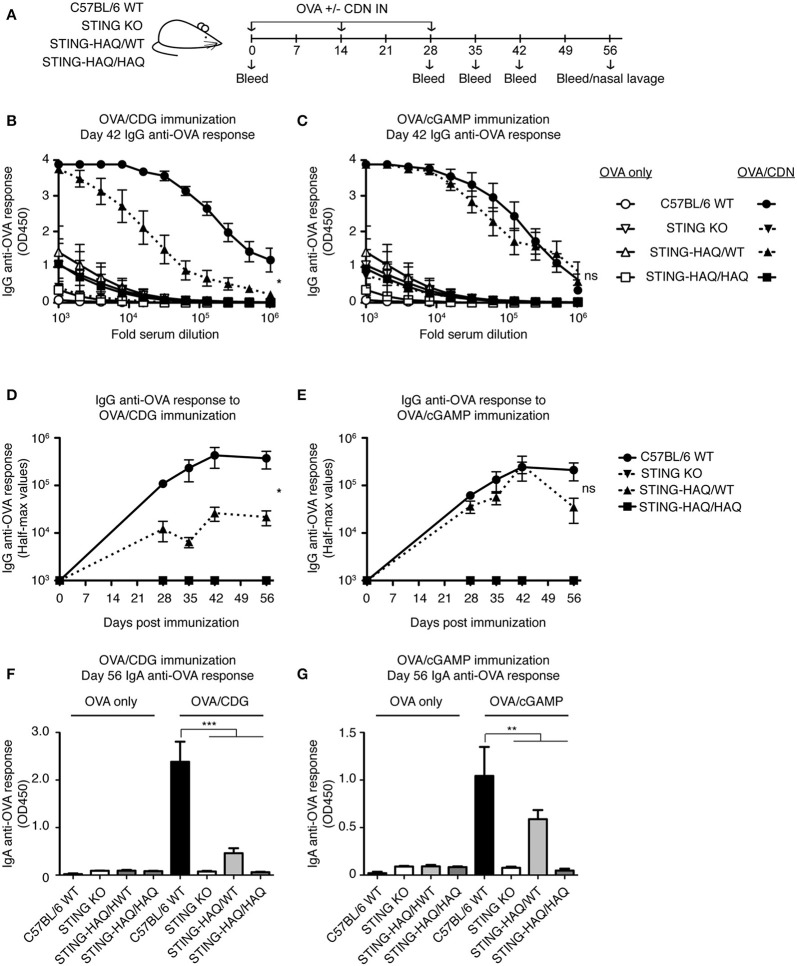
STING-HAQ homozygous mice are unresponsive to immunization with CDN adjuvant. (A–G) WT, STING KO and STING-HAQ/WT, and STING-HAQ/HAQ were immunized IN with 20 μg OVA with or without 5 μg CDG (B,D,F) or 5 μg 2′3′ cGAMP (C,E,G), and serum and mucosal anti-OVA antibody responses were monitored (n = 5). (A) Schematic representation of the experiment; (B,C) IgG anti-OVA response at d42 post-immunization, (D,E) Reciprocal half-max values of the OVA-specific IgG response; (F,G) OVA-specific IgA response in nasal wash at day 56. Data shown are representative of at least two independent replicate experiments. Bars in (B–G) represent mean ± SEM. NS P > 0.05; *P < 0.05; **P < 0.01; ***P < 0.001 using an unpaired Student's t-test.